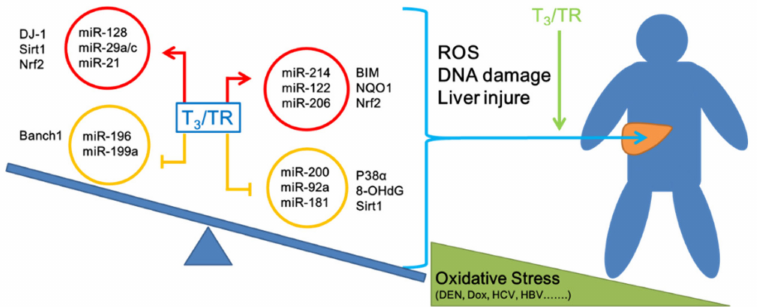
Figure 1. Thyroid hormones a ff ect oxidative stress-induced hepatocarcinogenesis through e ff ects on miRNAs. Oxidative stress is a risk factor associated with liver cancer. Among them, miRNAs strongly related to physiological significance are also involved. We analyzed the associations of thyroid hormones with oxidative stress and miRNAs in liver cells. While miRNAs related to promotion of resistance to oxidative stress were also a ff ected by thyroid hormones, based on empirical evidence from other experimental animal and clinical studies, we believe that thyroid hormone plays a largely hepatoprotective role under conditions of oxidative stress. (The red arrow is a positive association, the yellow T bar is a negative association, blue arrow indicates the miRNAs a ff ected liver genes, and green arrow is thyroid hormone associated-miRNAs a ff ected liver